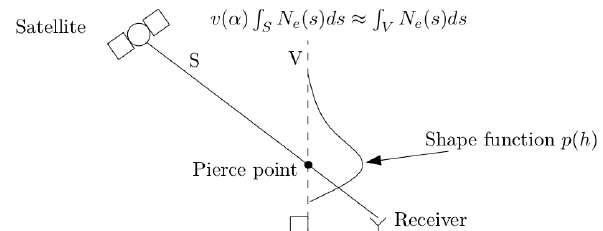
Figure 1. A scaled altitude profile model of the ionosphere assumes that the ionosphere locally has a fixed horizontally stratified altitude profile shape multiplied by a scalar. This makes it possible to relate slanted line integrals to equivalent vertical line integrals using an elevation-dependent scaling factor called the mapping function. The pierce point is located where the ray pierces the peak of the electron density